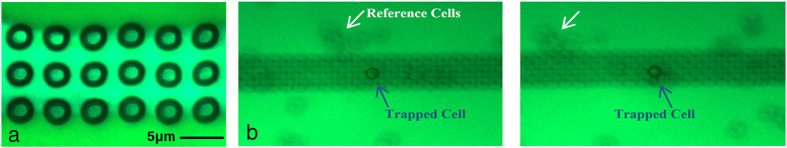
(a) An optical microscope image of the 2D PhC. (b) Images of yeast cells being trapped (left) and dragged (right) on the surface of the 2D PhC.